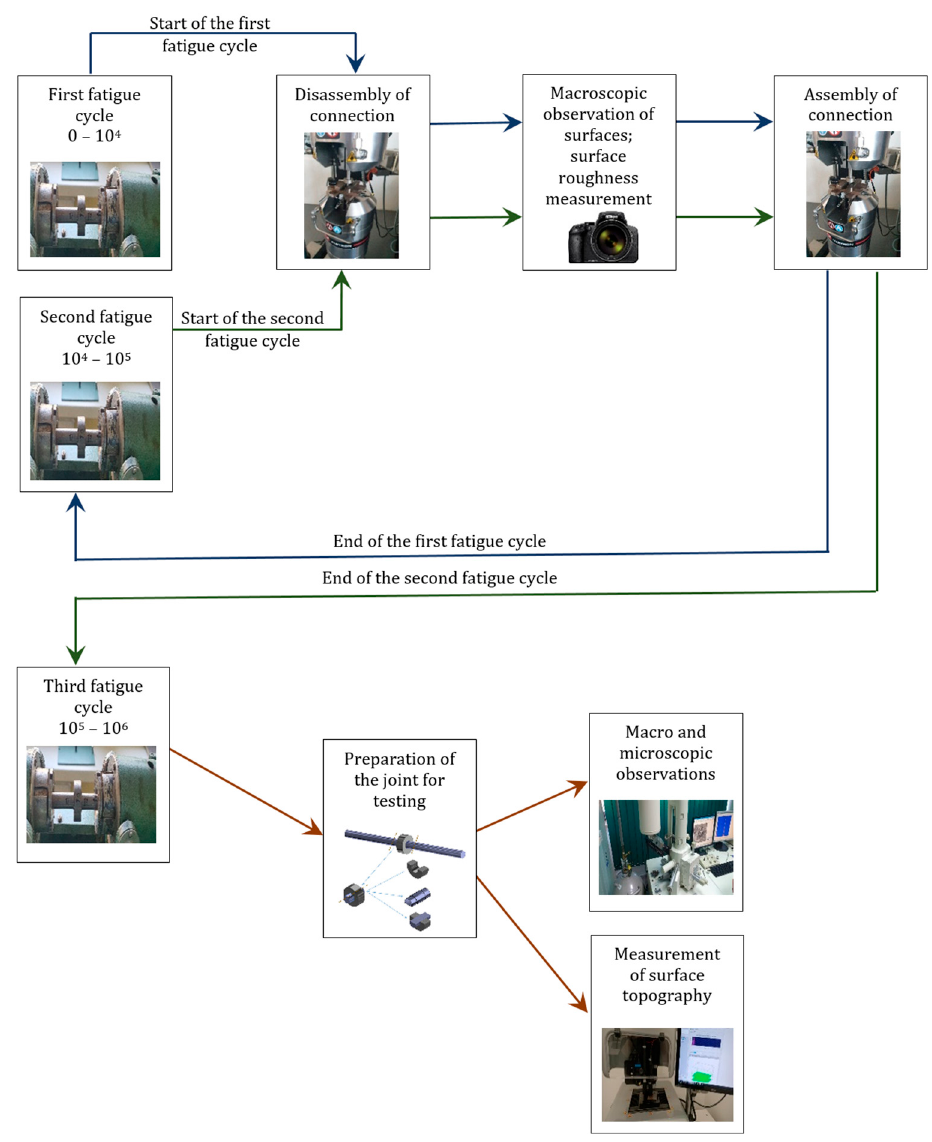
Figure 2. Test programme diagram.